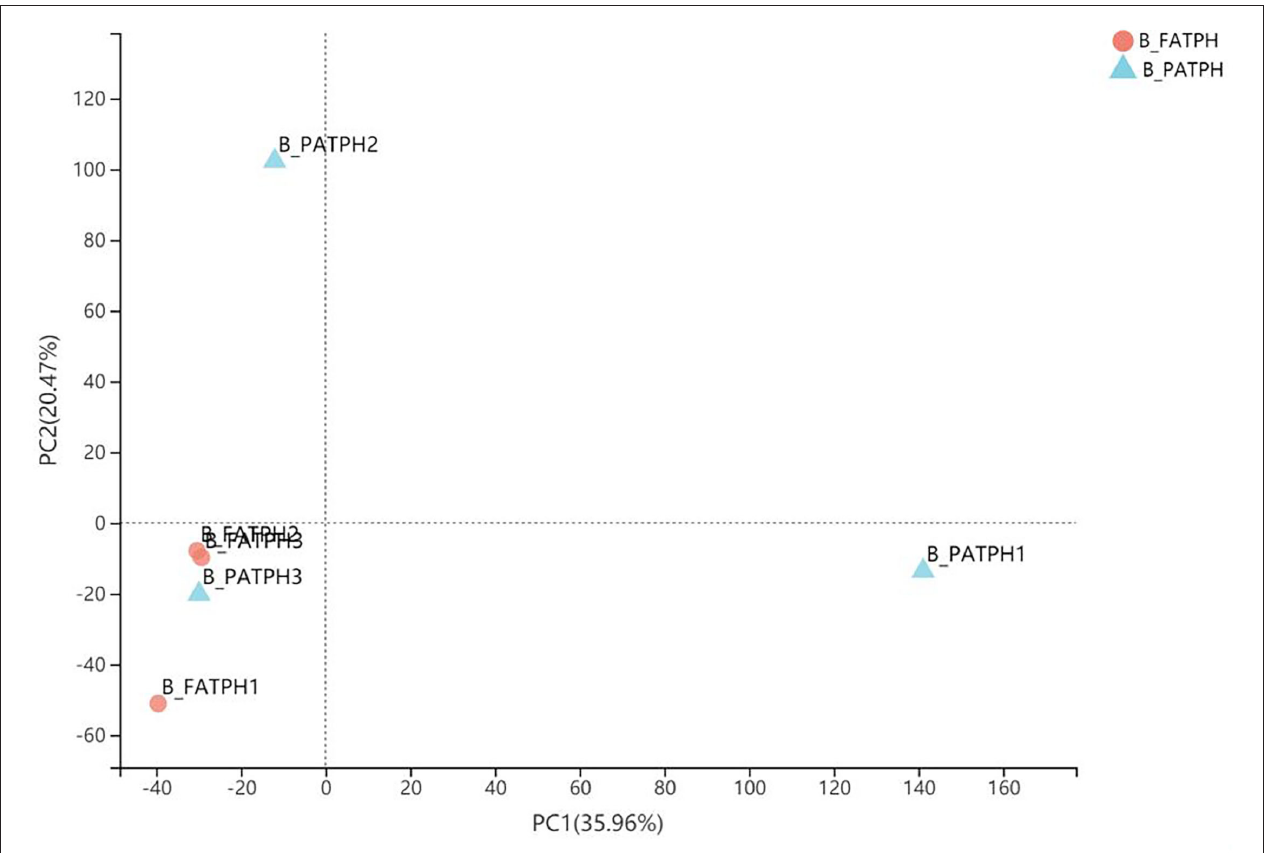
FIGURE 2 | PCA plot showing the differences in the total number of DEGs between B-PATPHs (blue) and B-FATPHs (red) based on RSEM software analysis and the TPM